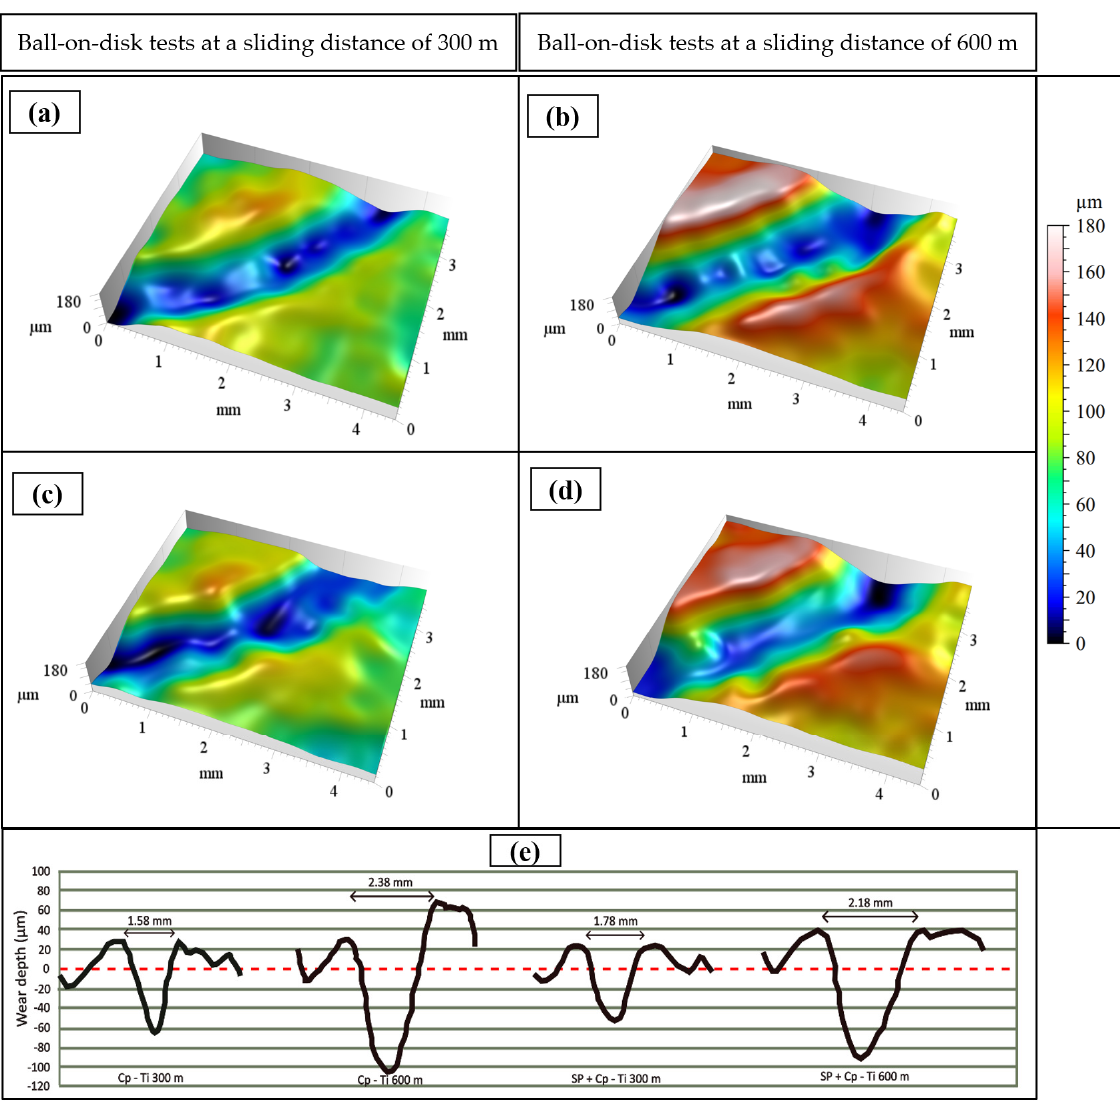
Figure 9. Low-resolution surface maps of ( a , c ) worn unpeened and ( b , d ) shot-peened samples at sliding distances of 300 m and 600 m and ( e ) wear depth profiles of unpeened and shot-peened samples at sliding distances of 300 m and 600 m.